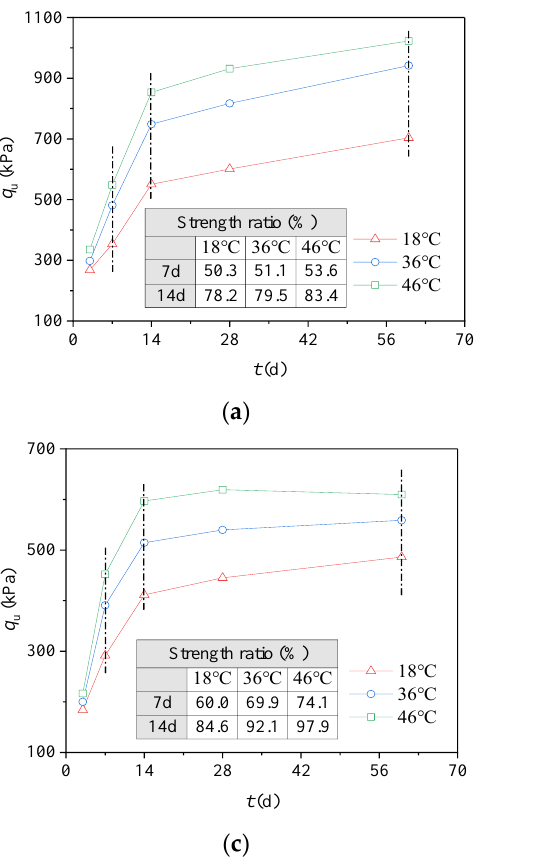
Figure 7. Relationship of q u - t at different C HA . ( a ) C HA = 0%; ( b ) C HA = 4%; ( c ) C HA = 7%; ( d ) C HA = 10%.